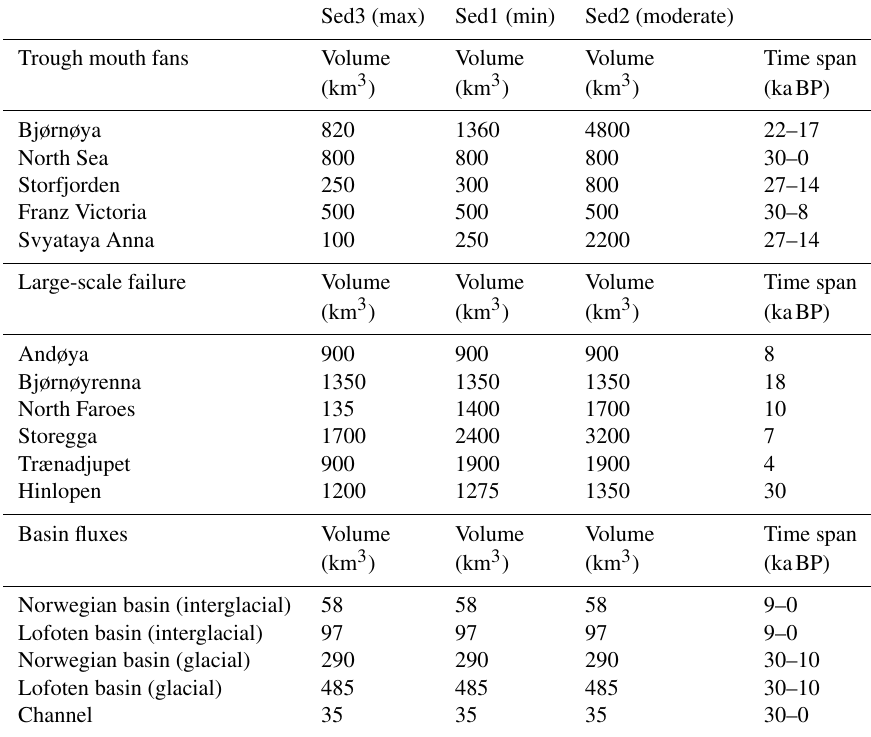
Table A4. Sediment estimates created from observations and estimates of individual estimates in Tables A1–A3, as described in the main text. Sed2 and Sed3 are the maximum and minimum models,